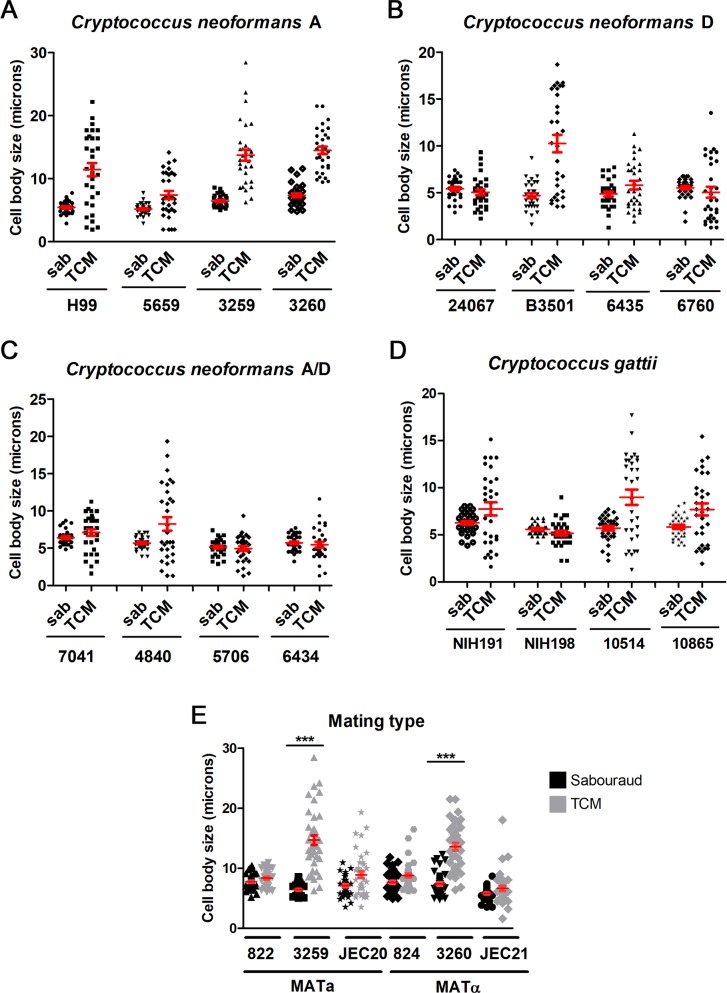
Titan-like cell induction in different strains.Four strains of each species (serotypes) were inoculated into Sabouraud (black symbols) or TCM (grey symbols) at a density of 104 cells/mL and grown overnight at 37°C with CO2. (A) C. neoformans var. grubii (serotype A); (B) C. neoformans var neoformans (serotype D); (C) C. neoformans A/D; (D) C. gattii. (E) MATa and MATα strains: NE822/NE824 (serotype D), 3259/3260 (serotype A) and JEC20/JEC21 (serotype D). Cell body size was measured in all cases. The red lines represent the mean and standard error.